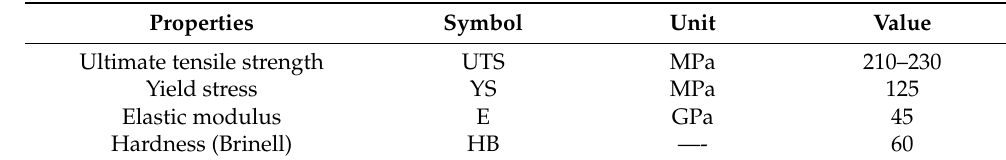
Table 3. Mechanical properties of AM50 magnesium alloy [49].